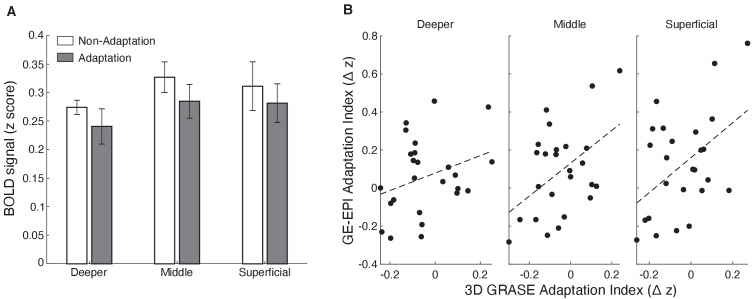
3D GRASE fMRI.(A) Mean z-scored BOLD (signal change from fixation baseline) measured with 3D GRASE for adaptation (grey) and non-adaptation (white) across cortical layers in V1. Decreased BOLD for the adaptation compared to the non-adaptation condition is shown across cortical layers. The difference between conditions was not statistically significant (condition × cortical depth: F(2,6)=0.875, p=0.432) due to the small sample size (N = 4). (B) Correlation of fMRI adaptation index for participants scanned with both GE-EPI and 3D GRASE sequences (N = 4) across cortical layers. Individual dots indicate fMRI adaptation index (z-scored BOLD for non-adaptation minus z-scored BOLD for adaptation), for each participant and run (Nruns = 5 for one participant; Nruns = 6 for one participant; Nruns = 8 for two participants) for GE-EPI (y-axis) and 3D GRASE (x-axis) sequences. Black dashed lines indicate correlation between GE-EPI and 3D GRASE fMRI adaptation index. Correlations were stronger for superficial (r = 0.465, p=0.019) and middle (r = 0.467, p=0.019) than deeper (r = 0.315, p=0.125) layers. This correspondence of results across sequences suggests that our results showing stronger fMRI adaptation in superficial and middle than deeper layers could not be simply due to vasculature confounds.